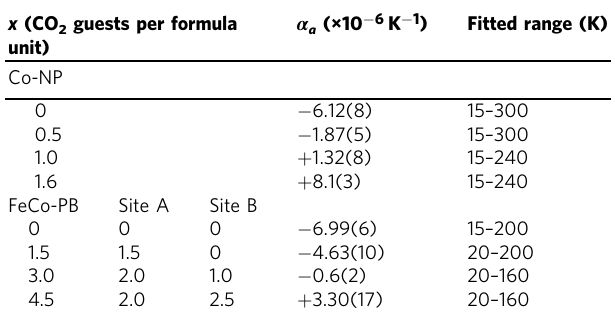
typical of guest-free PBAs 21 .